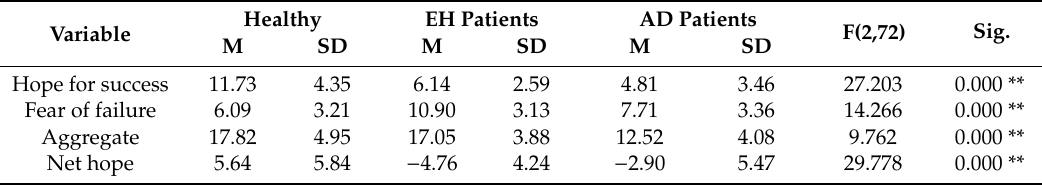
Table 3. Di ff erences in motivation measured by Heckhausen